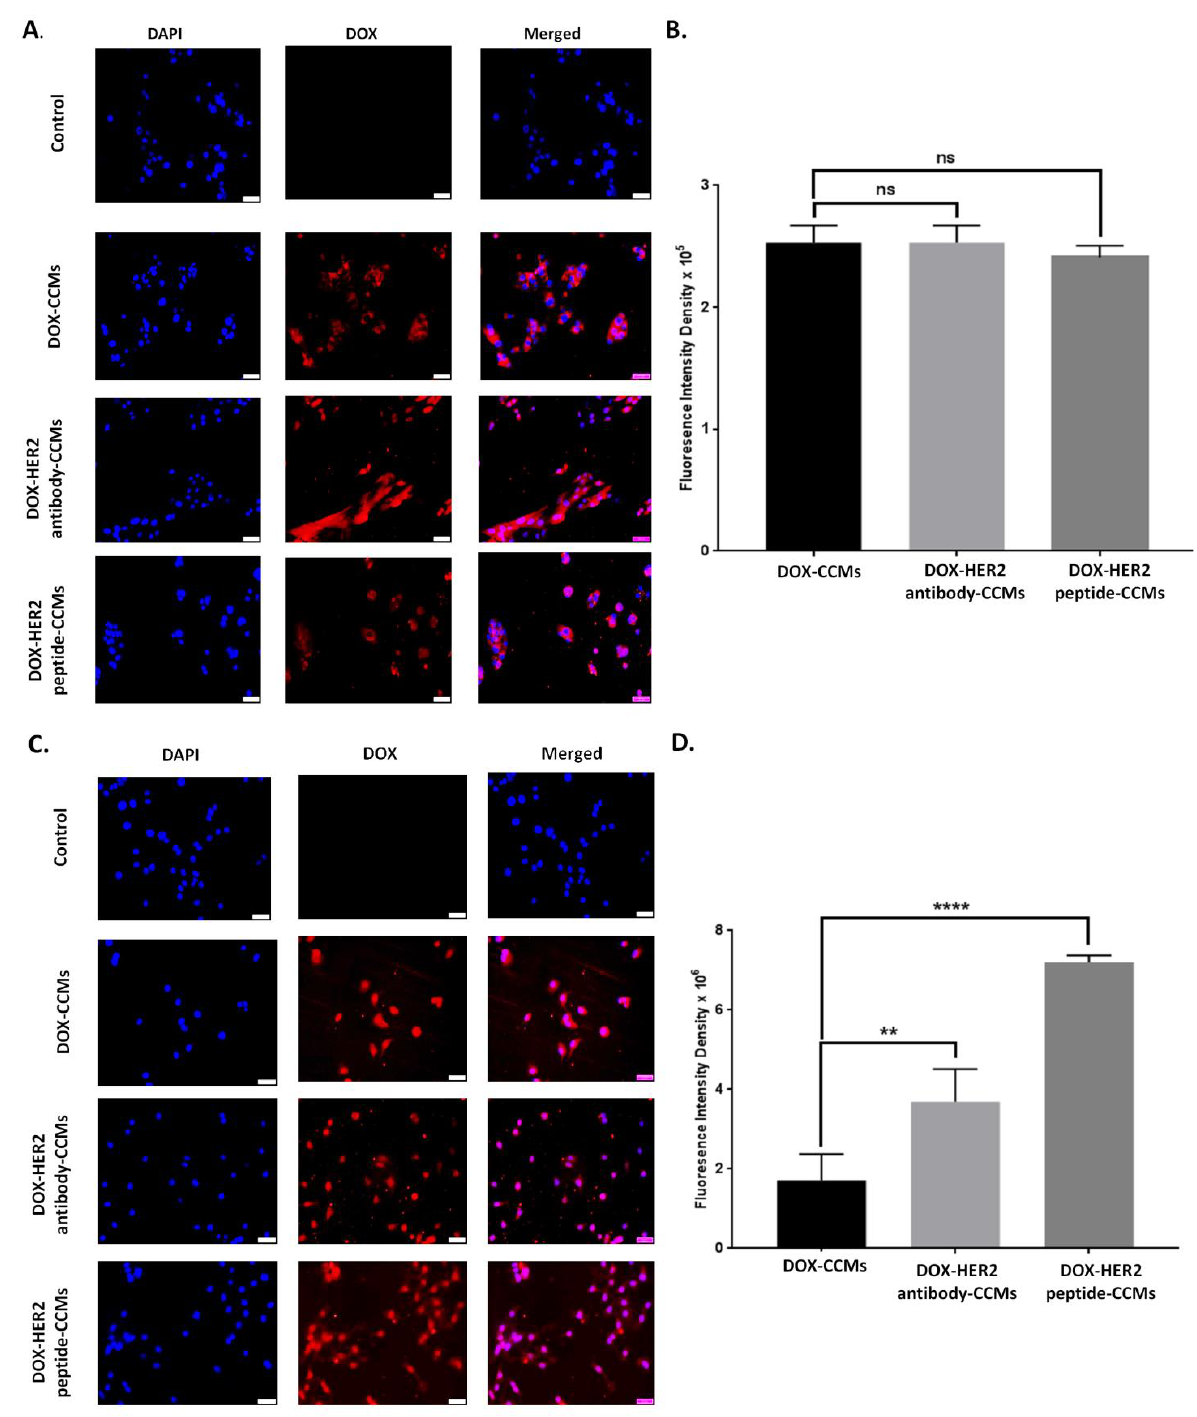
Figure 7. Fluorescence images and fluorescence intensity density of DOX-loaded HER2-peptide CCMs and HER2-antibody CCMs on MCF-10A ( A , B ) and SKBR-3 ( C , D ) cells at 48 h, Magnification: 20×, Blue: DAPI; Red: DOX. All experiments were tested and analyzed in triplicate, and repeated three times with similar conditions and paired t -test was performed for statistical analysis, and p < 0.01:**; p < 0.0001:**** were considered significant for 10 different image sections. The error bars represent the standard deviations. Non-significant was shown as